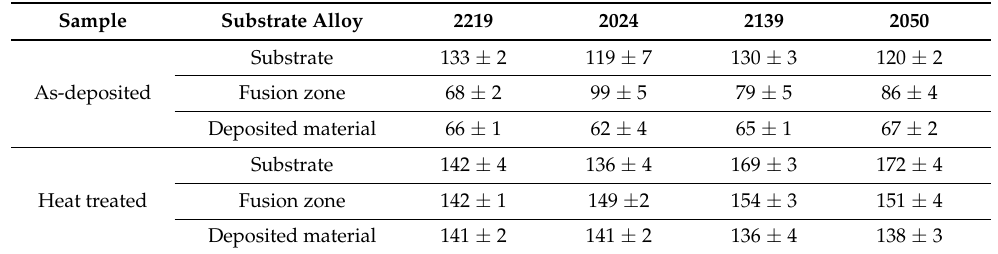
Figure 9. Vertical hardness profile before and after heat treatment for each alloy combination. Table 3. Average of the Vickers hardness values measured in the three areas of interest before and after heat